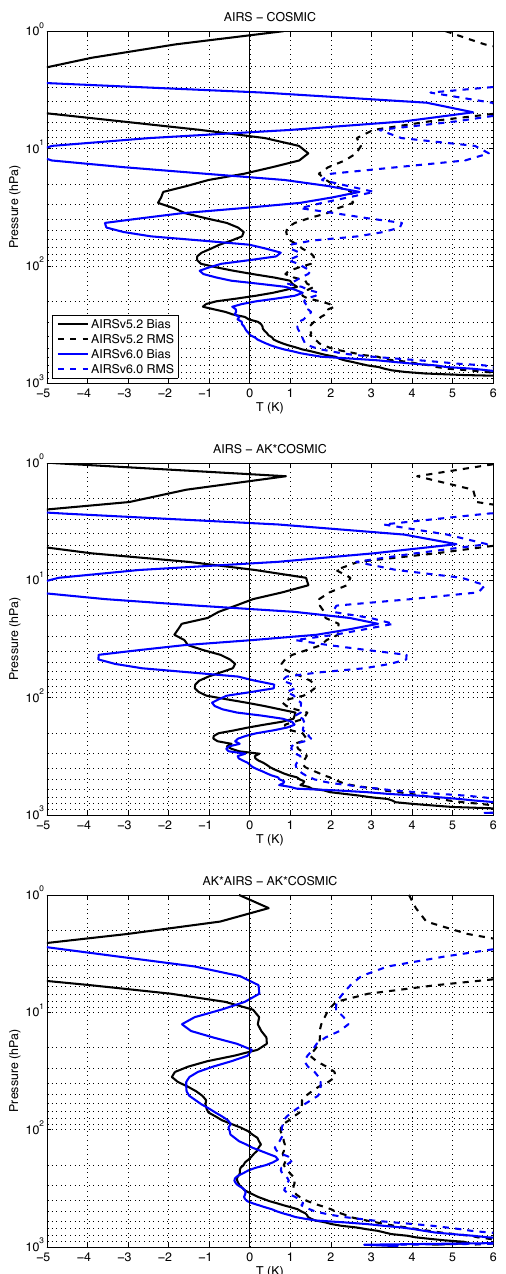
Figure 3. Antarctic May 2012 AIRS v5.2 minus COSMIC (black) and AIRS v6.0 minus COSMIC (blue) bias (solid) and rms (dashed) for the following three cases: (top) no averaging kernel applica- tion, (middle) AIRS averaging kernel application to COSMIC pro- files, and (bottom) AIRS averaging application to both COSMIC and AIRS profiles. The apparent large positive biases in the middle and lower troposphere are due to the comparison with the COSMIC dry temperatures, which are significantly lower than actual temper- atures when significant amounts of water vapor are